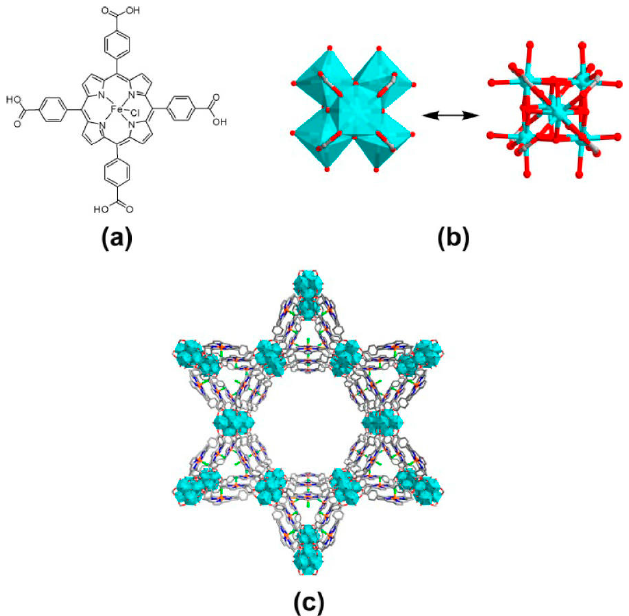
Molecules 2016 , 21 , 1348 14 of 18 Figure 10. Schematic representation of porphyrin@MOFs type-catalysts. (Colour scheme: bright green = Cu, gray = H, dark gray = C, light blue = N, red = O, sky blue = metal in the porphyrin core, purple = porphyrin representation). MMPF-6 previously mentioned in the Section 2.2, constructed via the self-assembly of the [tetrakis( p -carboxyphenyl)porphyrinato] iron(III) chloride ligand with in situ generated Zr 6 O 8 (COO) 8 (H 2 O) 6 SBUs (Figure 11), was further examined as catalyst in the peroxidase activity experiments commonly used to assess the biomimetic activity of synthetic biocatalysts. Both reactions involve the oxidation of a substrate: for the first, the oxidation of 1,2,3-trihydroxybenzene (Scheme 7) specifically